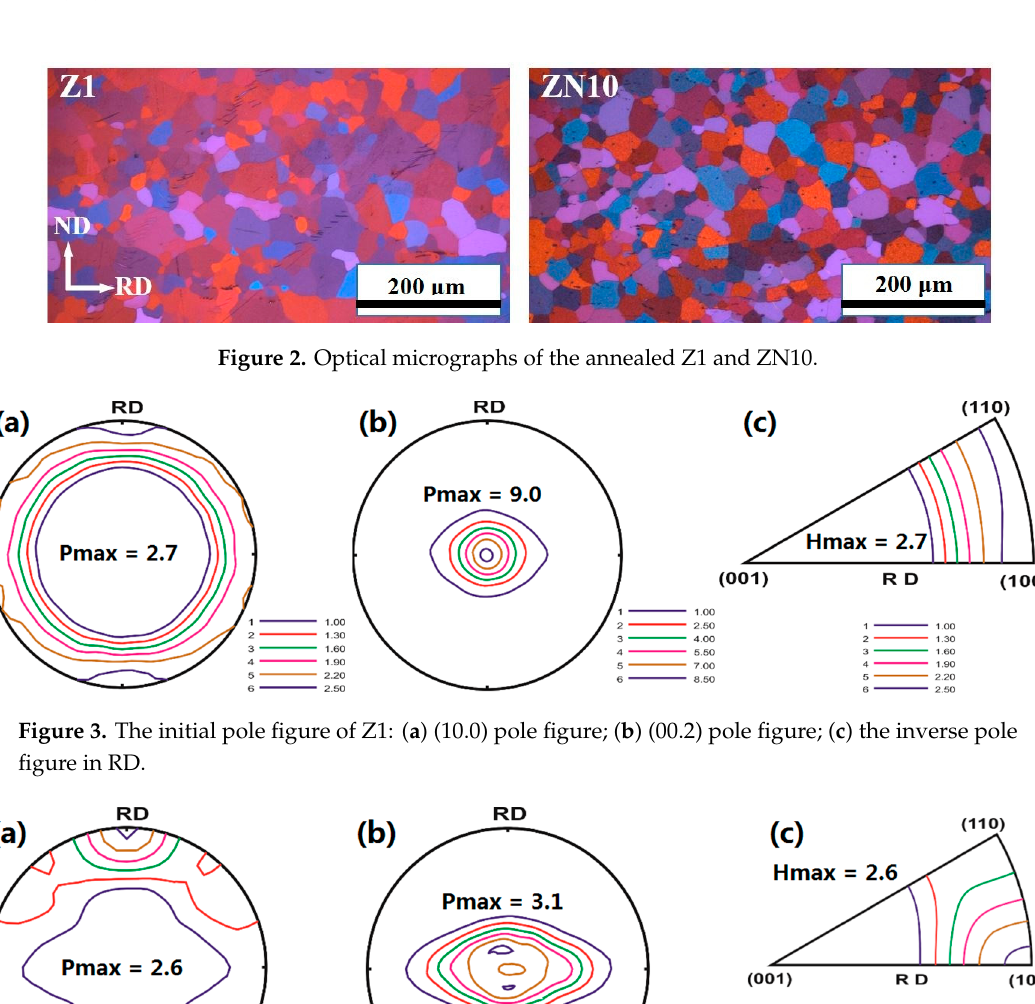
Figure 3. The initial pole figure of Z1: ( a ) (10.0) pole figure; ( b ) (00.2) pole figure; ( c ) the inverse pole figure in RD.